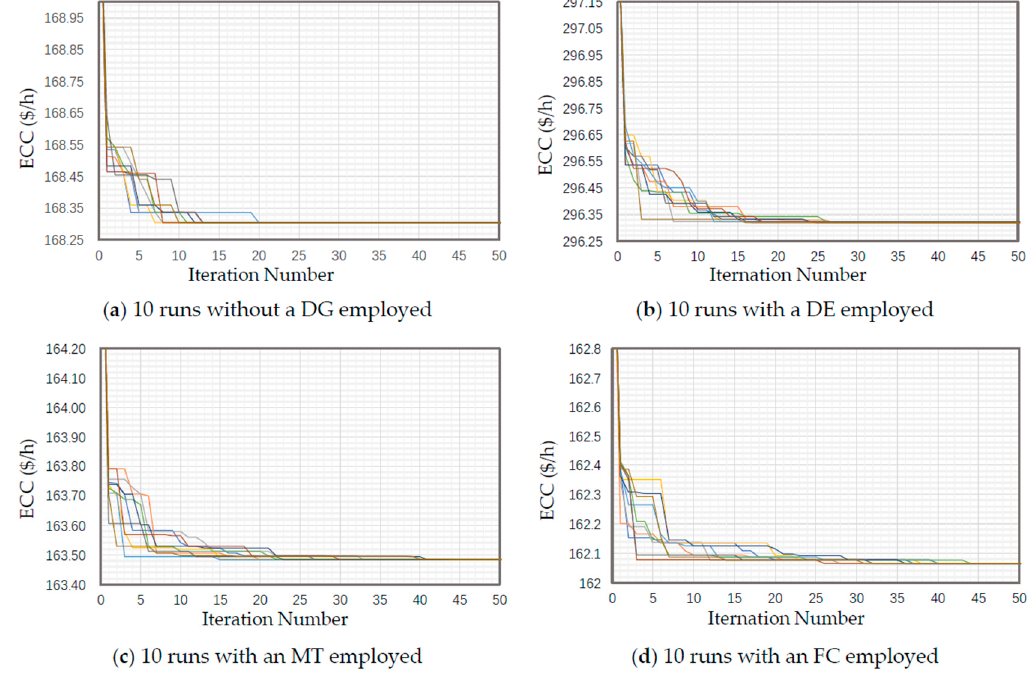
Figure 5. The convergence of the proposed algorithm on